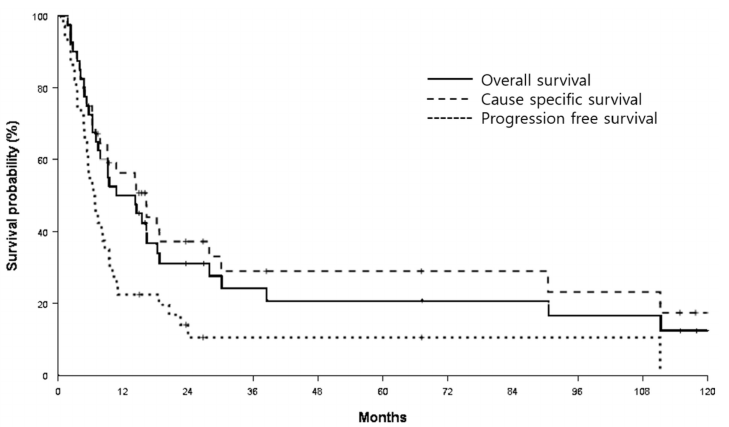
Figure 1. Overall survival (OS), cause-specific survival (CSS), and progression-free survival (PFS) outcomes. Median OS and CSS times were 10.8 months and 16.3 months. Median PFS time was 6.5